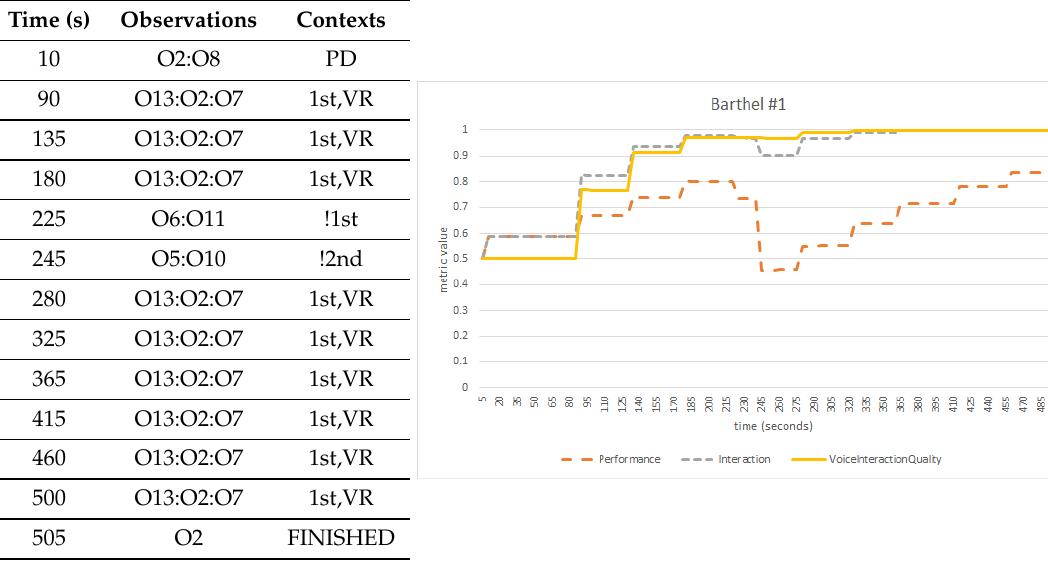
Table 10. Barthel(patient) #1: (Left) Contexts and observations generated by the system: 1st (First